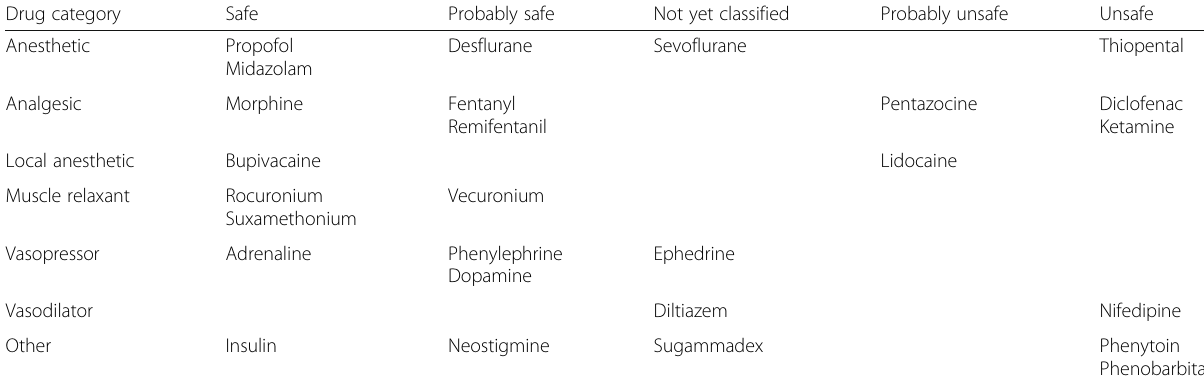
Table 1 Recommendations for anesthesia-related drugs in patients with porphyria. This table was created independently by the authors based on data from references [10 –